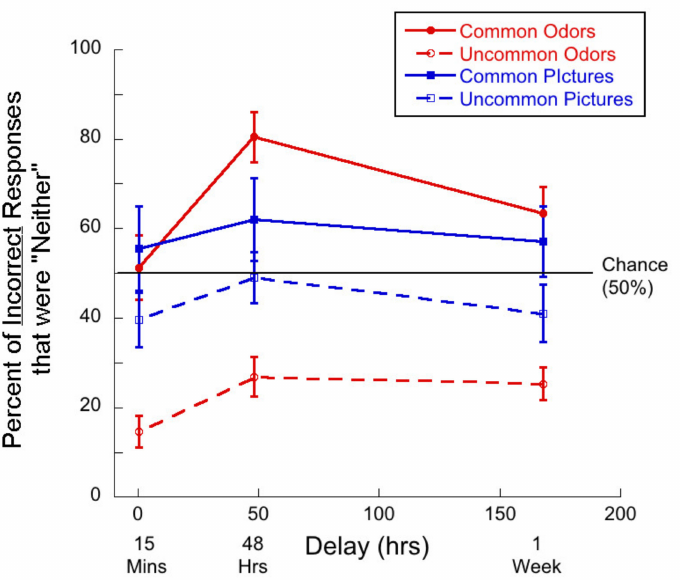
Figure 3. Percentage of incorrect responses that were “neither” responses as a function of delay for each of the four test conditions. Note that “neither” was never a correct response. Given that there were two ways to arrive at an error, chance is